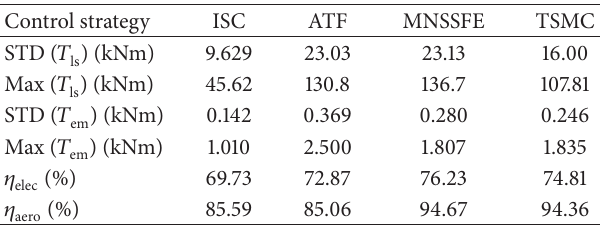
Table 2: Comparison of different control strategies based on two- mass model using FAST simulator.